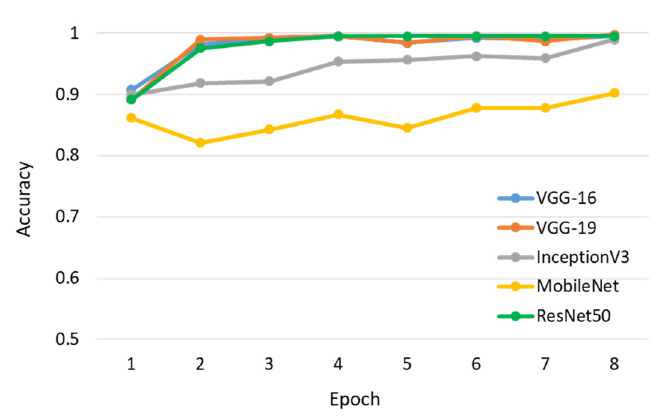
Figure 16. Training accuracy for different CNN-based networks.